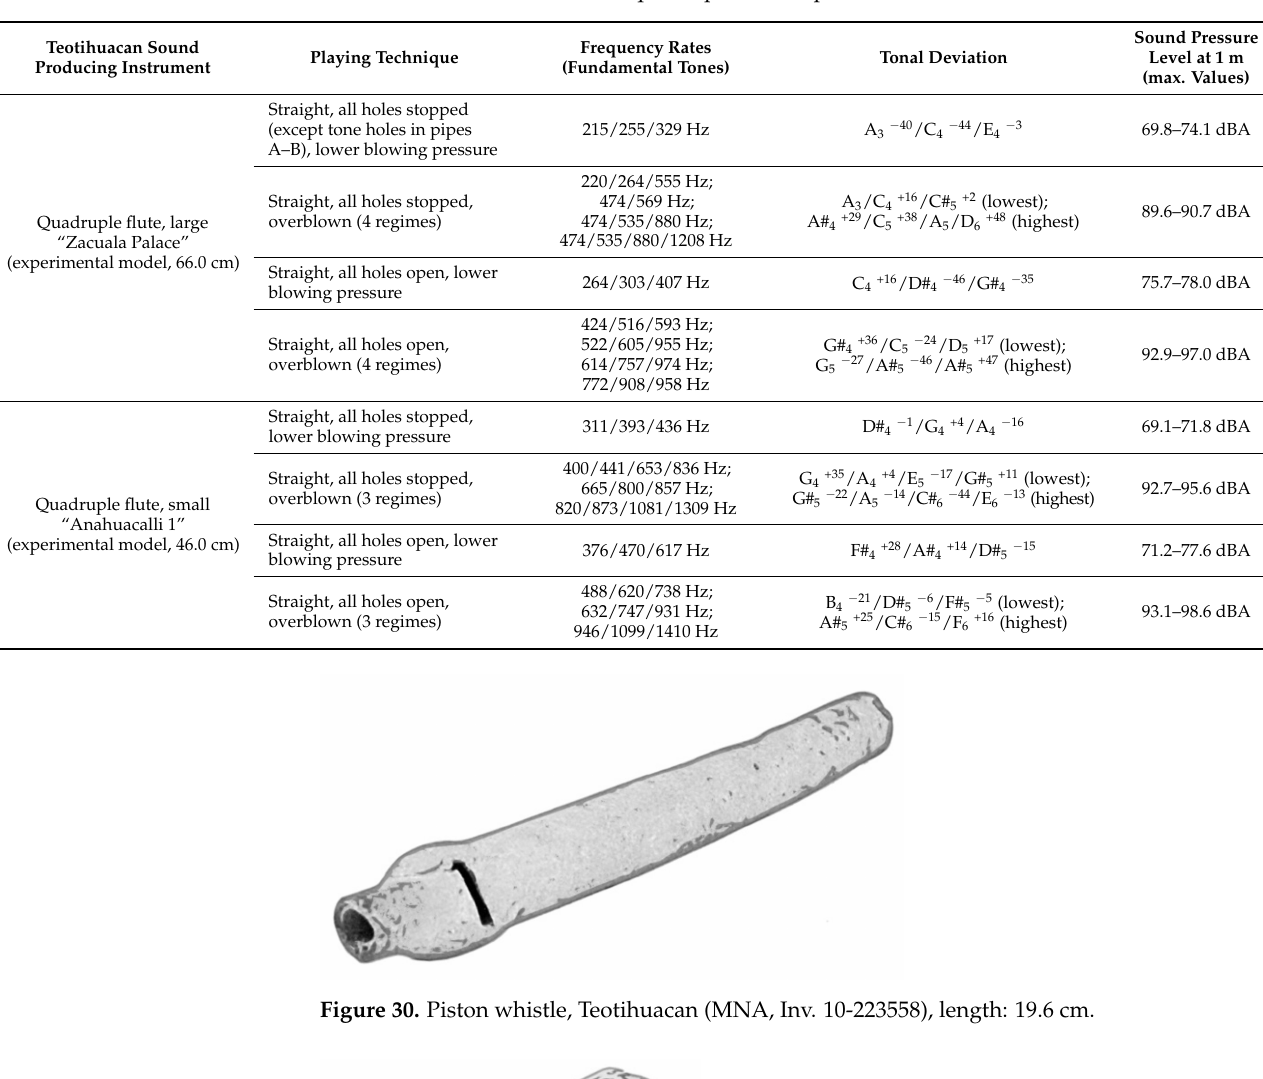
Table 5. Acoustic data sheet of the quadruple flute experimental models.